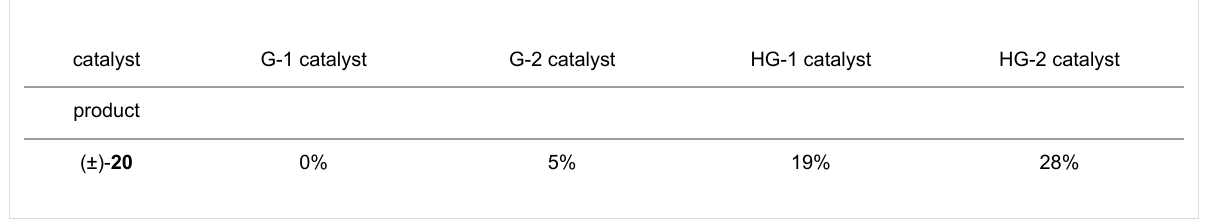
Table 6: Isolated yields for compound (±)- 20 formed in the reaction of lactam (±)- 19 in CM reactions with various catalysts.